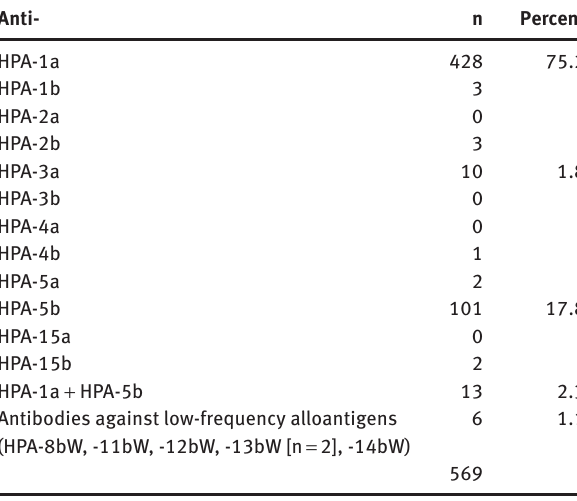
Table 3: Antibodies identified in 569 cases of FNAIT [59], percentage is indicated for frequencies above